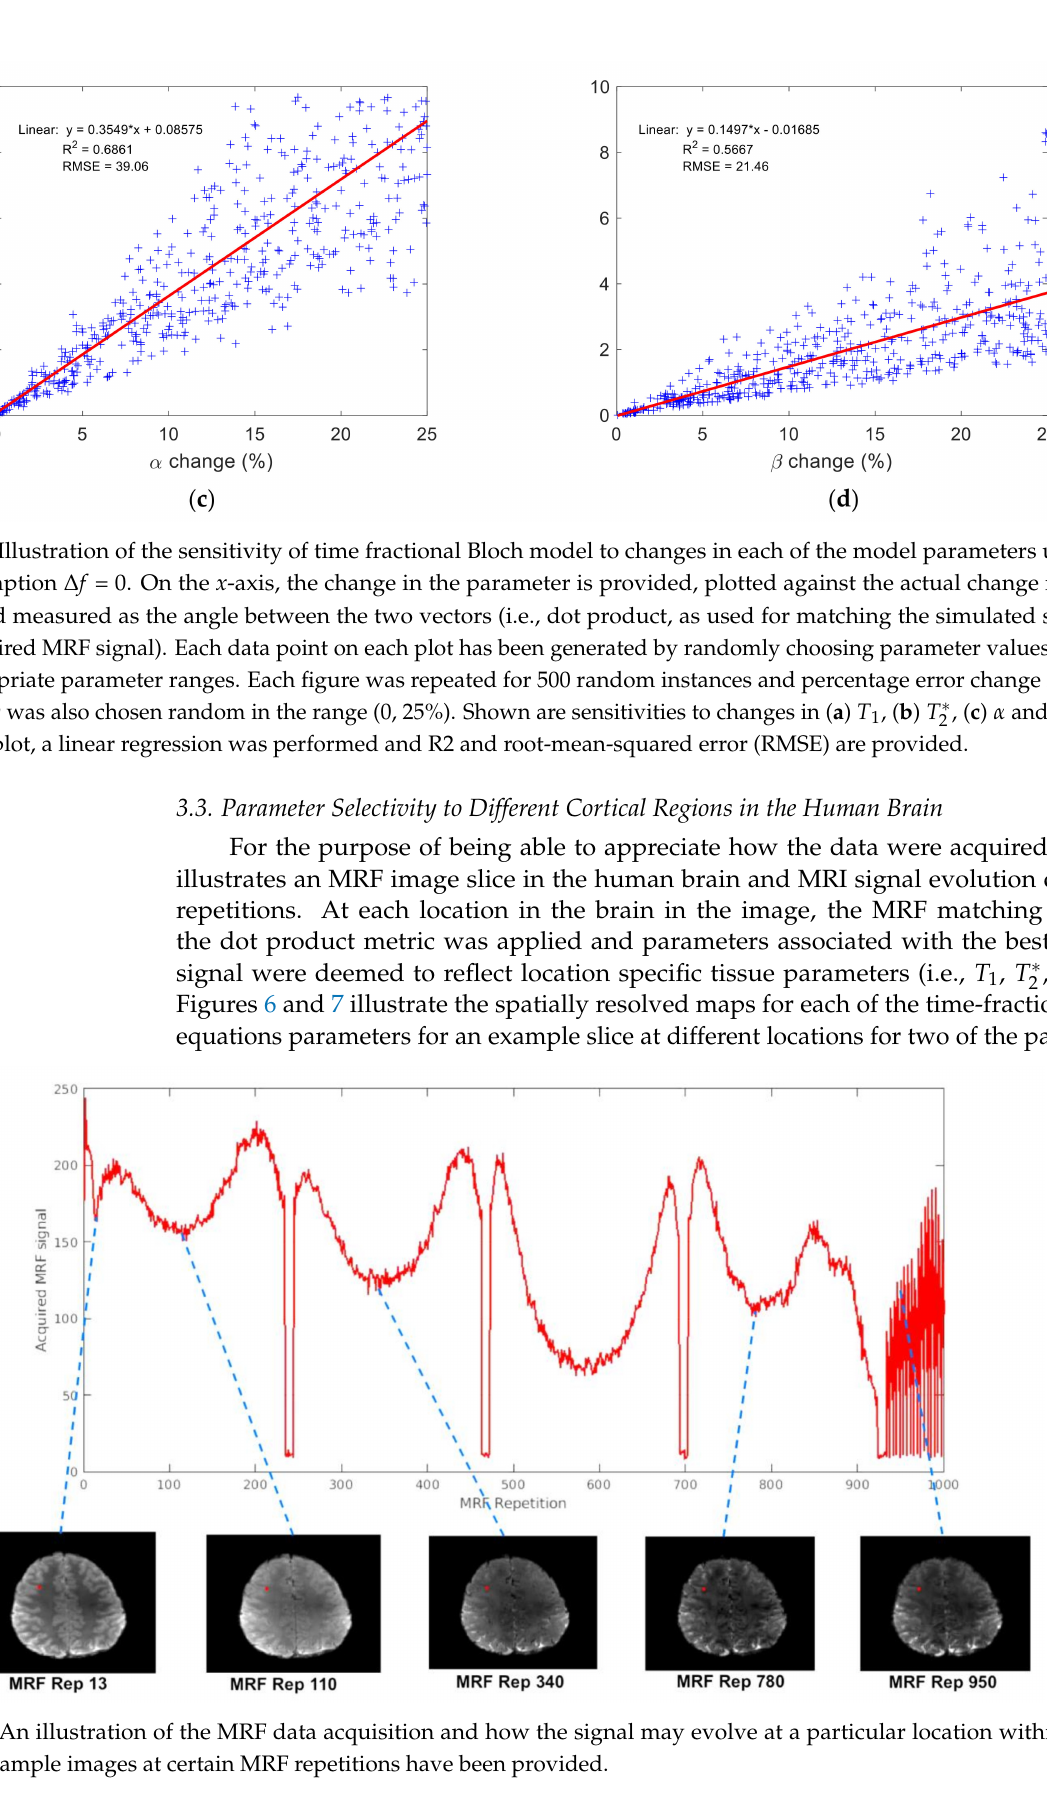
Figure 5. An illustration of the MRF data acquisition and how the signal may evolve at a particular location within the image. Example images at certain MRF repetitions have been